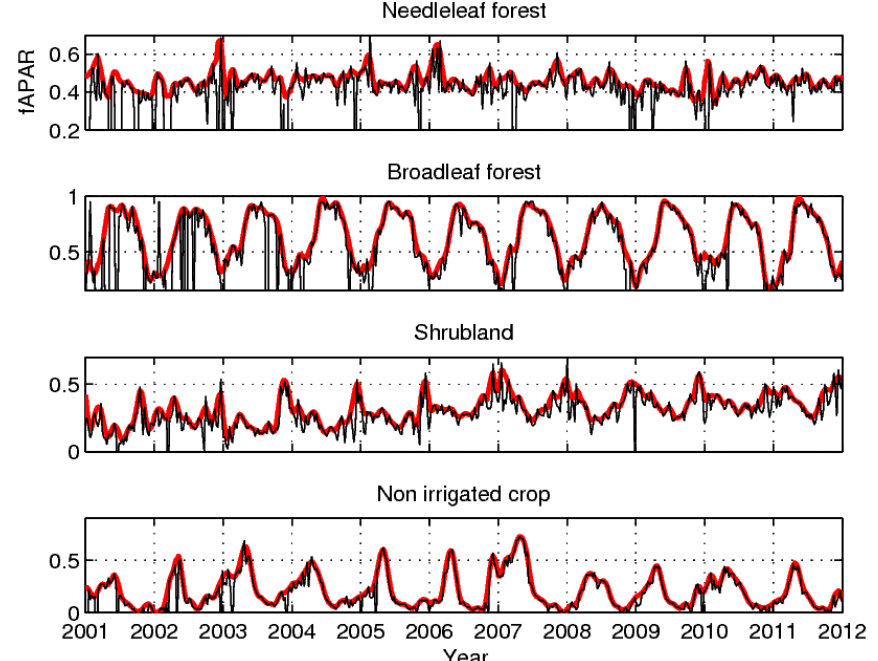
Figure 8. Application of the optimized LOESS method on real MODIS data. Black line corresponds with unfiltered fAPAR data and red line with the filtered